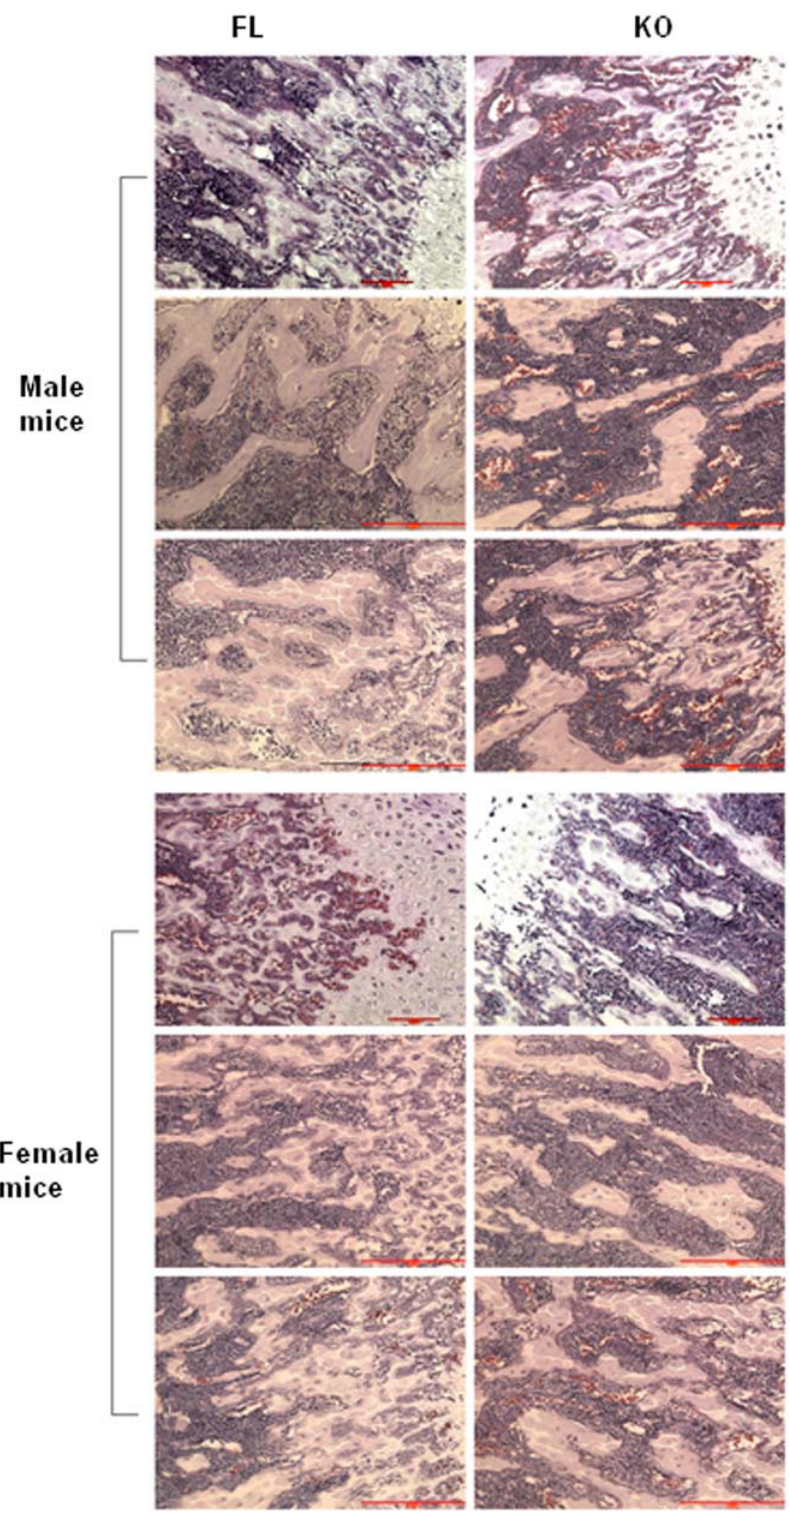
Figure 8. Histology of femurs from FL and KO mice. Masson’s Trichrome staining of bones in male and female OGR1 FL and KO mice. Nuclei were stained black, cytoplasm was red, muscle fibers were red, and collagen was blue. Scale bar=100 m m.